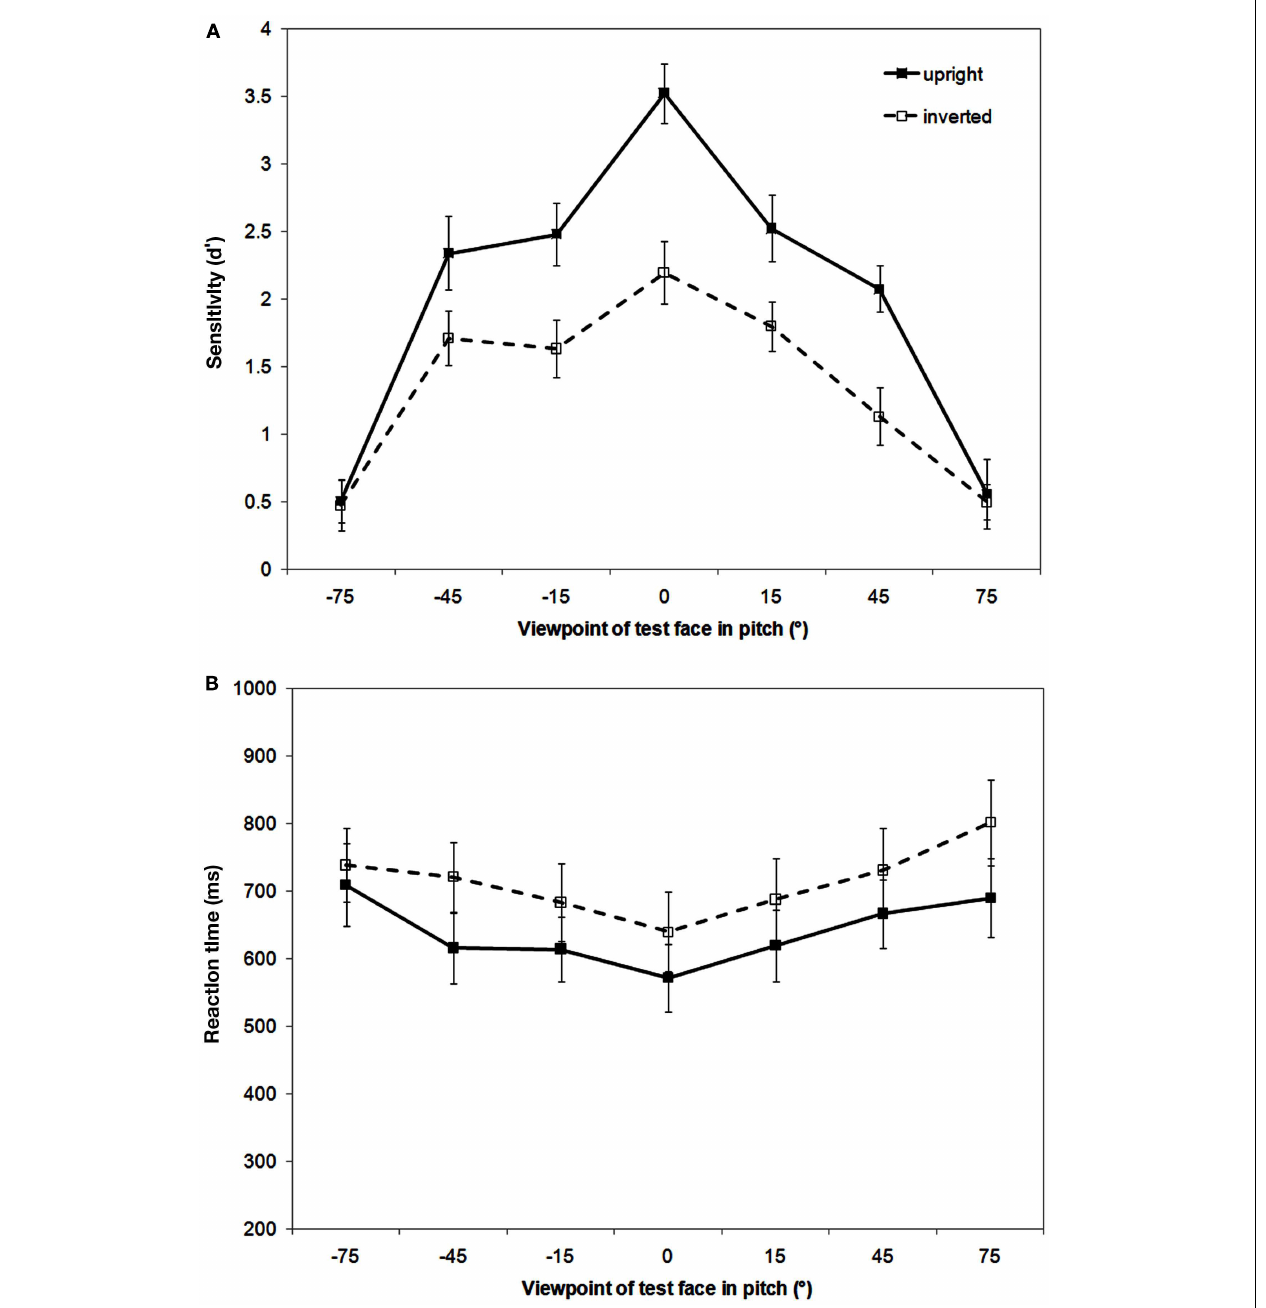
FIGURE 2 | Results of the sequential matching task showing mean recognition sensitivity [ d (cid:48) (A)] and reaction time [ms (B)] as a function of pitch viewpoint (where – refers to viewpoints below 0˚ and + refers to viewpoints above 0˚) and orientation (upright and inverted). Error bars represent 1